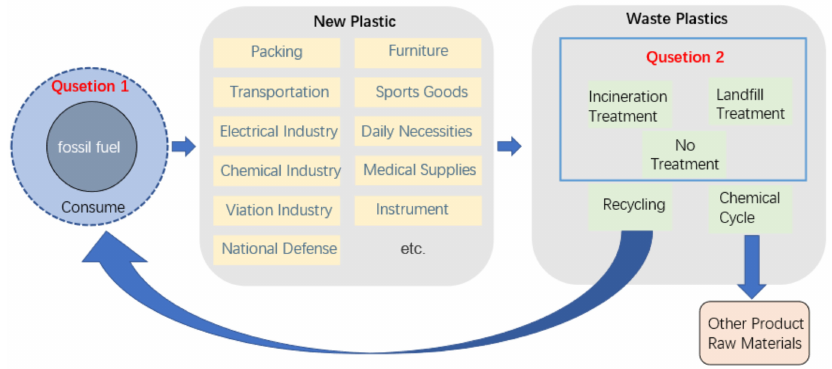
Figure 1. Problems of